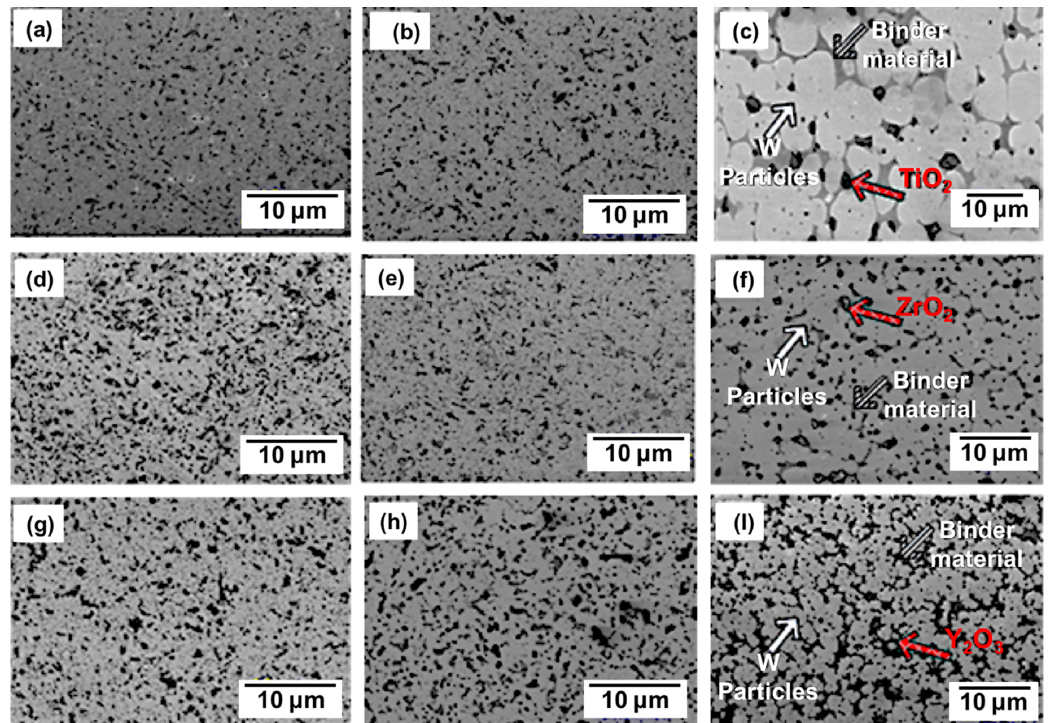
Figure 2. ( a – I ) Microstructures of oxide dispersing strengthening (ODS) tungsten heavy alloys by SEM numbered from one to nine according to the Taguchi orthogonal array, as listed in Table 1.